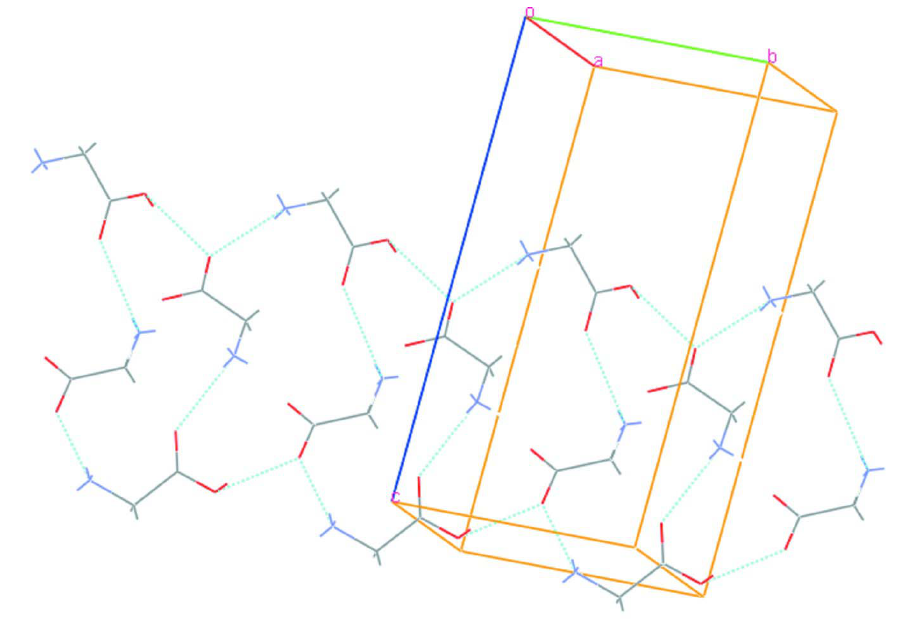
Figure 3 Cyclic chain between the glycine molecules generating a graph set motif R 44 (19). Glycinium hydrogen fumarate glycine solvate monohydrate Crystal